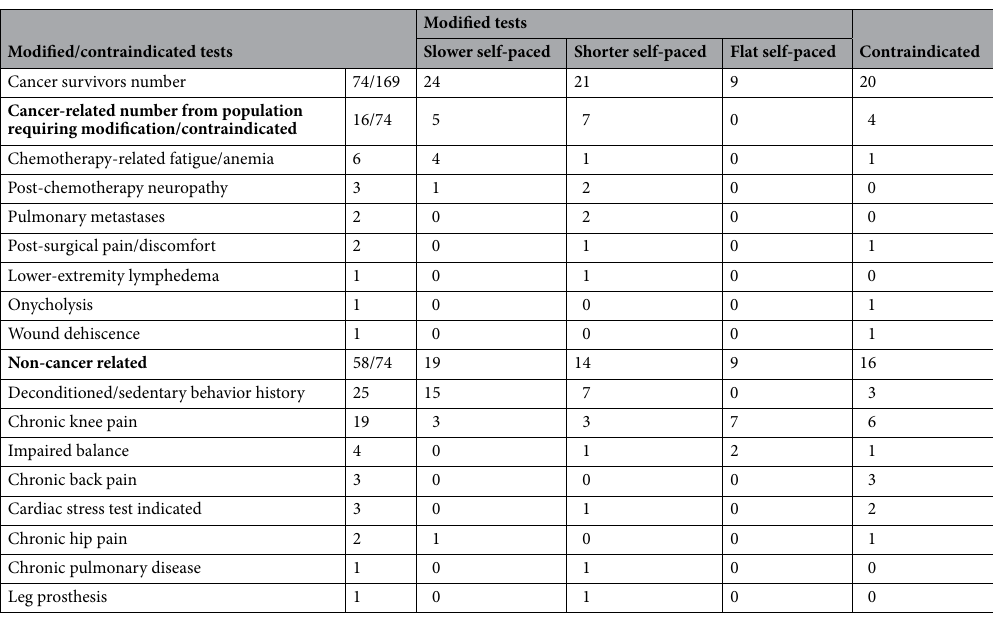
Table 4. Co-morbidities requiring step test modification or